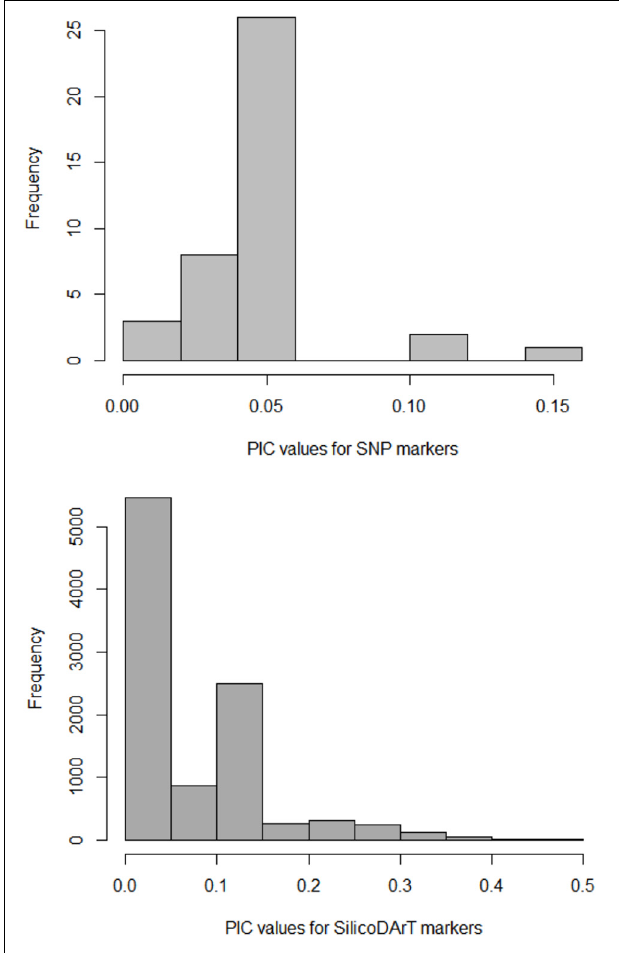
FIGURE 4 | Frequency distribution of polymorphic information contents (PIC) values for SNP and SilicoDArT markers.